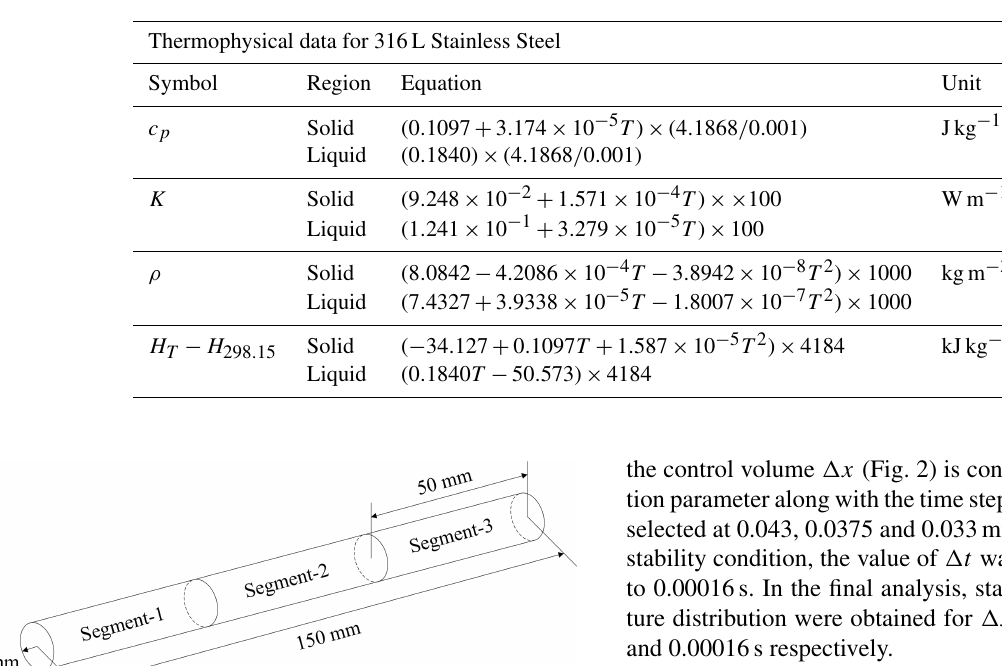
Figure 3. (a) Flow chart describing the relevant steps taken within the non-commercial code. (b) Flow chart describing the relevant steps taken within subroutine of the non-commercial code. Table 3. Thermophysical data for the solid and liquid region of 316L stainless steel.